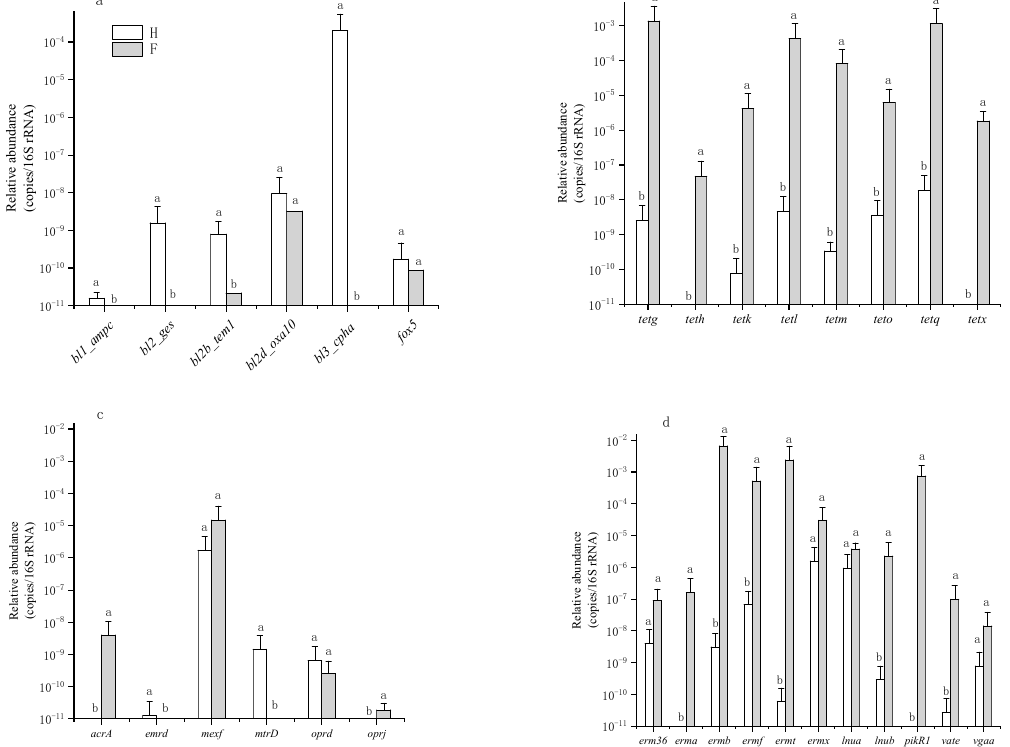
Figure 4. The ARG composition by principle component analysis (PCA). H: hospital; F: farm; C: city residence; V: village residence.